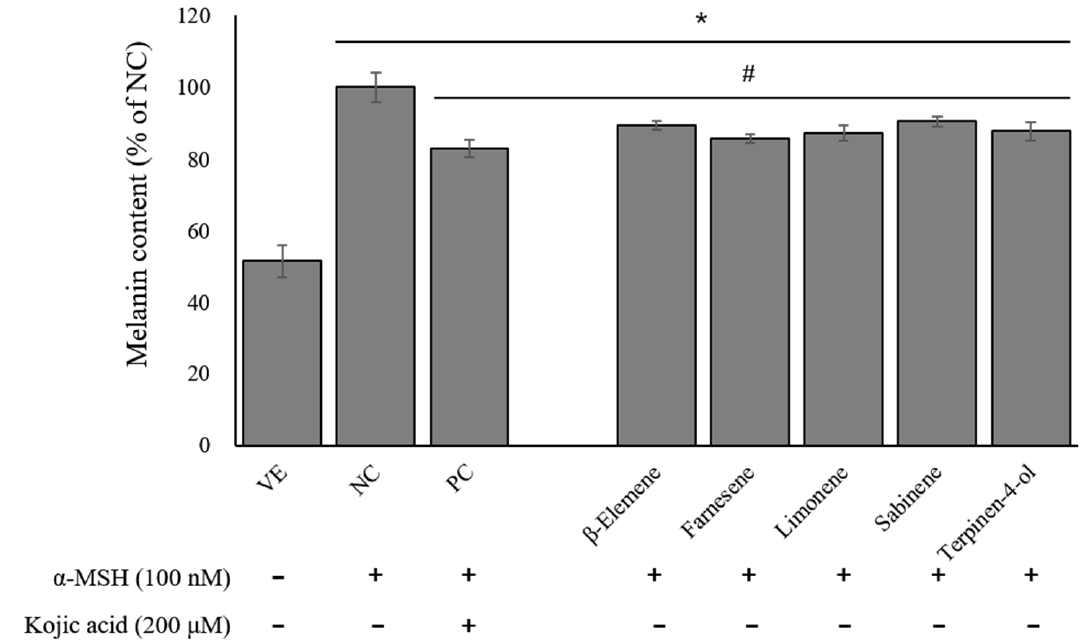
Figure 8. Effects of single compounds on melanin contents. Values are presented as means ± standard deviations. Note: * p < 0.05 compared to VE; # p < 0.05 compared to NC. VE, vehicle group; NC, 100 nM α -MSH; PC, 200 µM kojic acid.